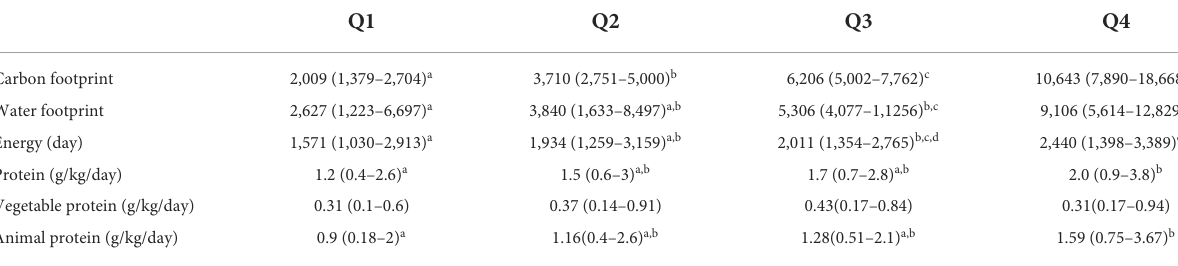
TABLE 4 Energy and protein intake and environmental footprints across quartile of carbon footprint.